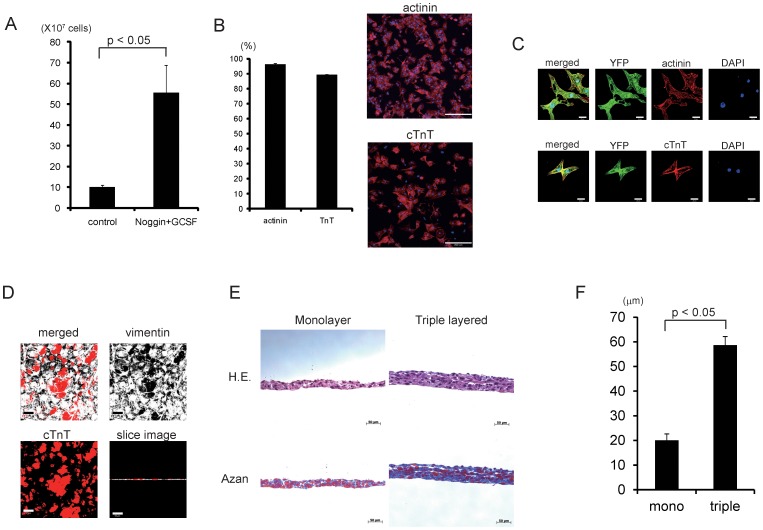
Liter-scale cultivation and cardiac cell sheet creation.(A) The number of remaining cells at 8 days after neomycin treatment (n = 4). (B) Almost all remaining cells after neomycin treatment were cardiomyocytes. Left, the percentage of contractive protein-expressing cells. Right, representative images of high content confocal microscopy to analyze cardiomyocyte purity. Cardiac contractive proteins (sarcomeric α-actinin, upper; cTnT, lower) are shown in red. Nuclei were counterstained with DAPI (blue). Bars, 200 µm. (C) Representative images of cardiac contractive protein expression (red) in the remaining cells after G418 selection in the bioreactor system. Nuclei were counterstained with DAPI (blue). Scale bars, 20 µm. (D) Distribution of cardiomyocytes (cTnT, red) and fibroblasts (vimentin, white) in a monolayer cardiac cell sheet. Scale bars, 50 µm. (E) Histological analyses of layered cardiac cell sheets. Stacked cell sheets were subjected to HE and azan staining. Left panels are images of monolayered sheets. Right panels are images of triple-layered cell sheets. Scale bars, 200 µm. (F) Thicknesses of cell sheets (n = 3).